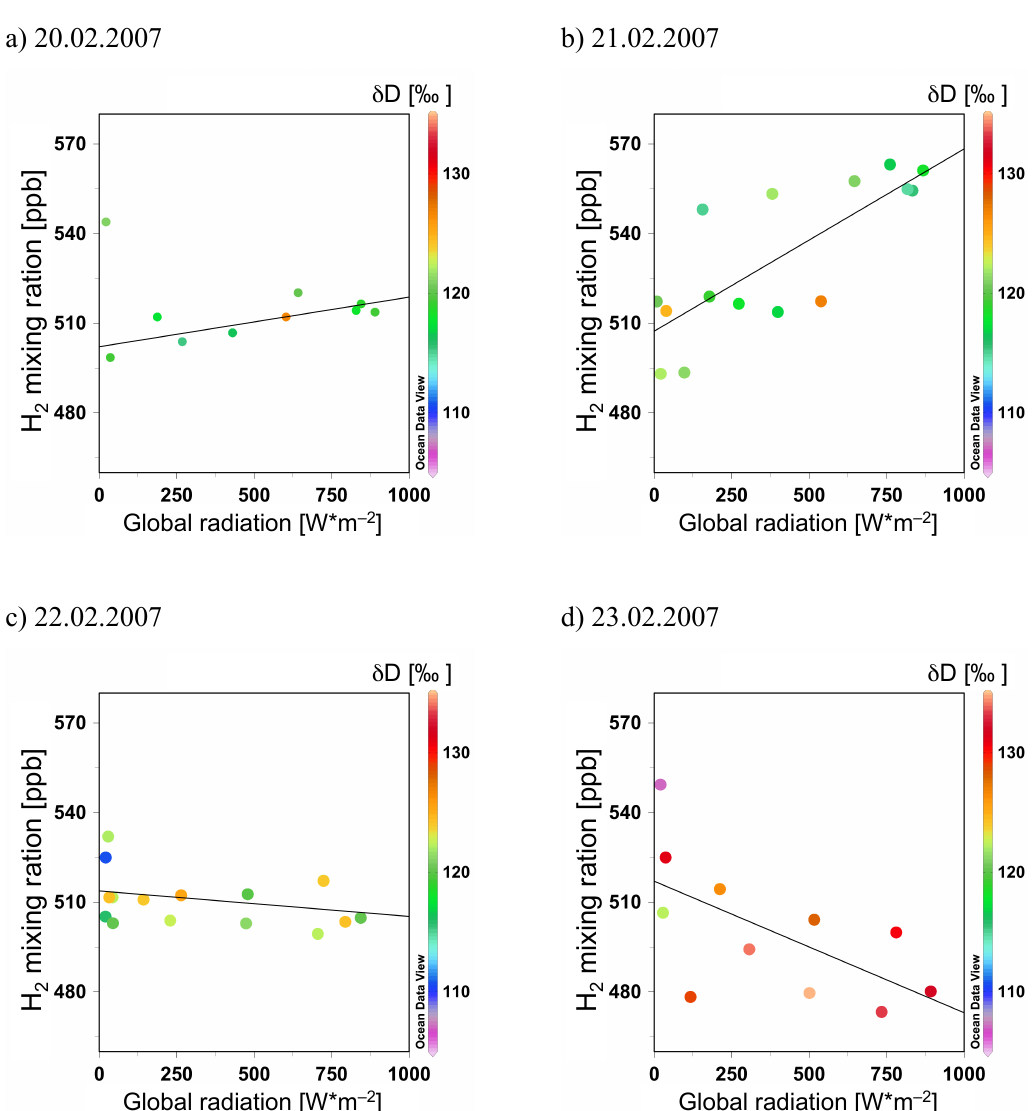
− 2 ) with color-coded δ D (‰) during the four high-resolution sam- Figure 4 Fig. 4. Correlation between H 2 mixing ratio (ppb) and radiation (Wm pled days 2007. (a) : 20 February 2007, excluding 1 outlier (07:31UTC), y = 0.0167 x + 502.14, r = 0.771, n = 9; (b) : 21 February 2007, y = 0 . 061 x + 507.38, r = 0.784, n = 15; (c) : 22 February 2007, y =− 0 . 009 x + 513.79, r = –0.311, n = 16; and (d) : 23 February 2007, y =− 0 . 044 x + 517.04, r =− 0.618, n = 11 (Schlitzer, 2012). Table 1. Sampling location and weather conditions during the four high-resolution sampled days (POS 348,